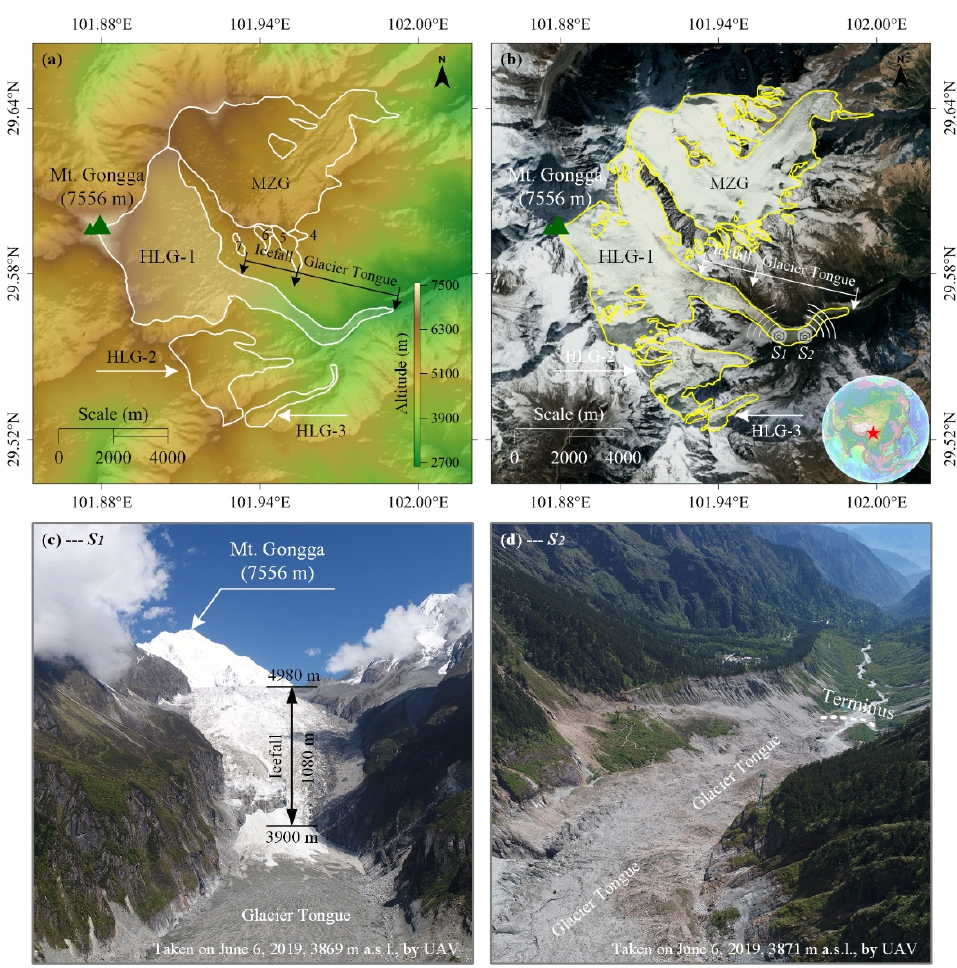
Figure 1. Topographic map ( a ) and Google Earth optical image ( b ) of the test area. The white ( a ) and yellow ( b ) lines illustrate the glacier boundaries from SCGI and GGI, respectively. ( c , d ) photographs of HLG-1 taken at the stations shown as “ S 1 ” and “ S 2 ” of ( b ), respectively.